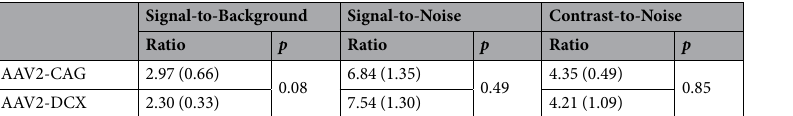
Table 1. Signal intensity and image quality measures of retinal ganglion cell labelling with the two AAV vectors. Signal-to-background ratio measured the intensity ratio between the signal and background, signal-to-noise ratio and contrast-to-noise ratio represents the image quality at 5-weeks post-injection. Ratios are expressed as mean (95% CI). No statistically significant difference was found for any